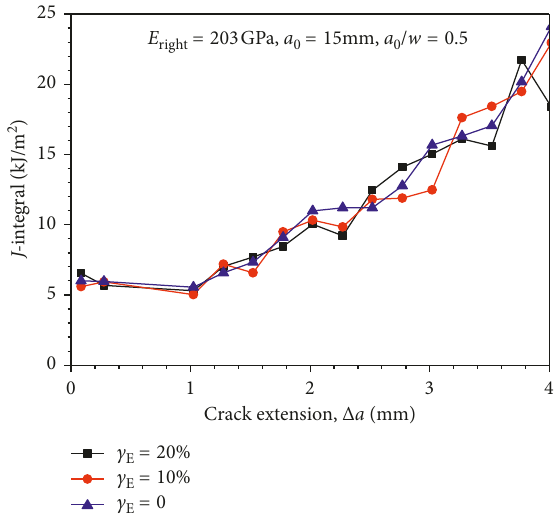
Figure 11: J - Δ a curves of elastic modulus mismatch specimen.